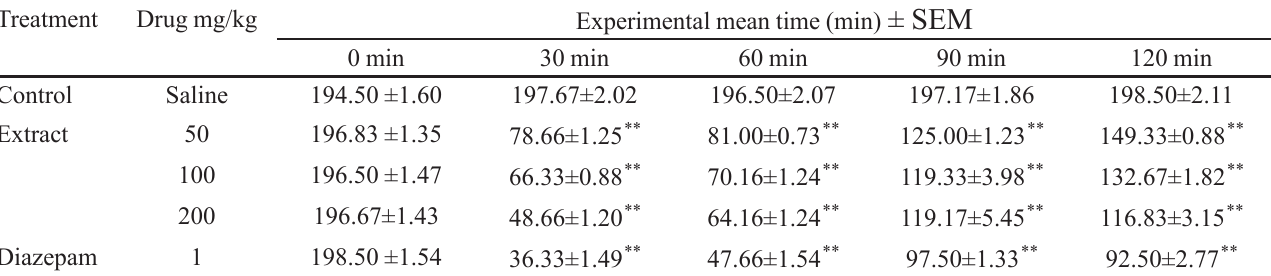
TABLE II - Effect of PO extract on motor coordination in mice Treatment